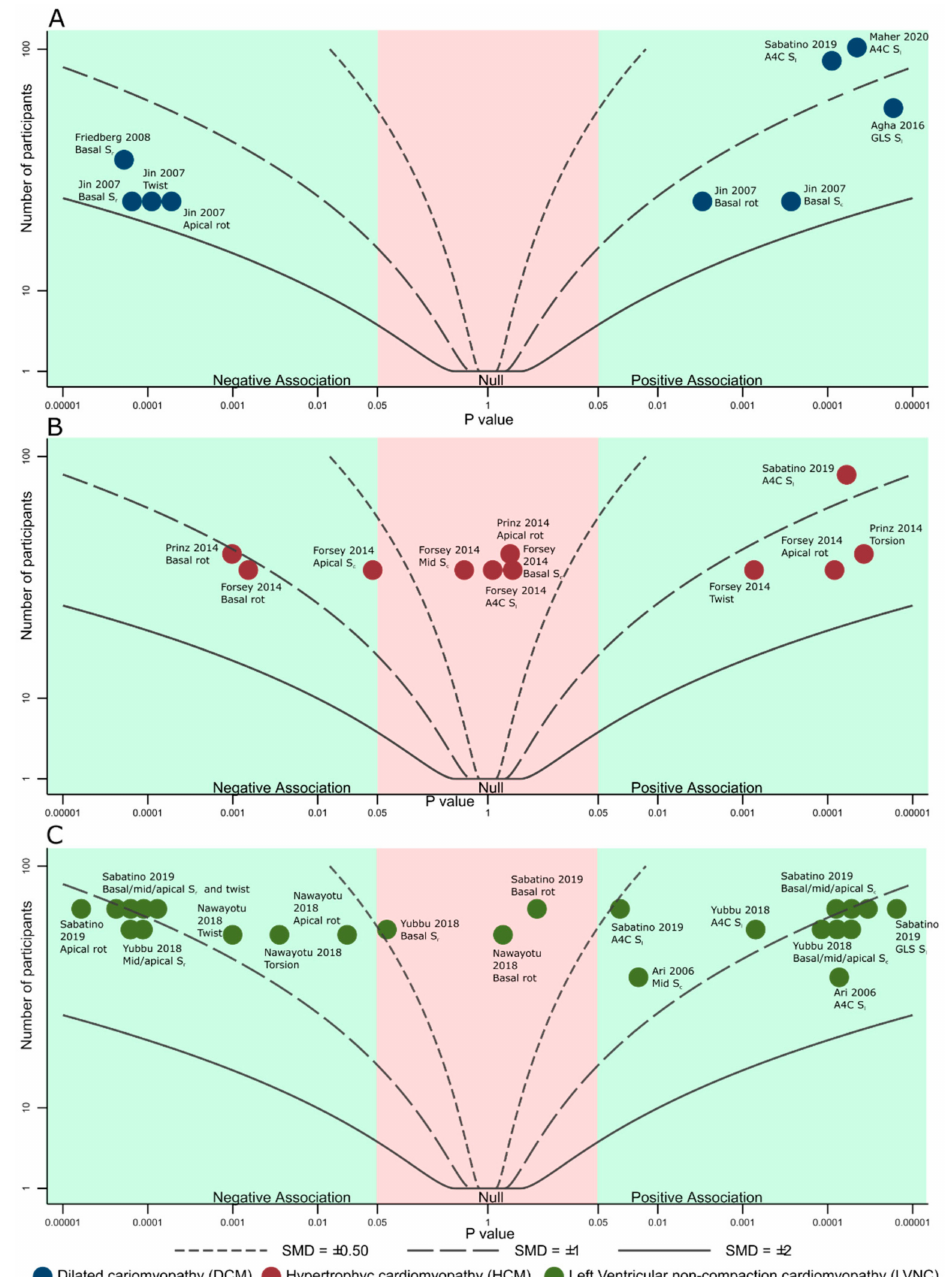
Figure 2. Albatross plot showing estimated standardized mean differences contours (curved lines), p values for difference between inherited cardiomyopathy and controls (horizontal axis) and study sample size (vertical axis) of speckle tracking measurements by cardiomyopathy type in ( A ). Dilated cardiomyopathy; ( B ). Hypertrophic cardiomyopathy ( C ). Left ventricular non-compaction. Negative association–lower values (including more negative) associated with disease; positive association–higher values (including less negative) associated with disease. A4C, apical four chamber view; GLS, global longitudinal strain; rot, rotation; S l , longitudinal strain; S c , circumferential strain; S r , radial